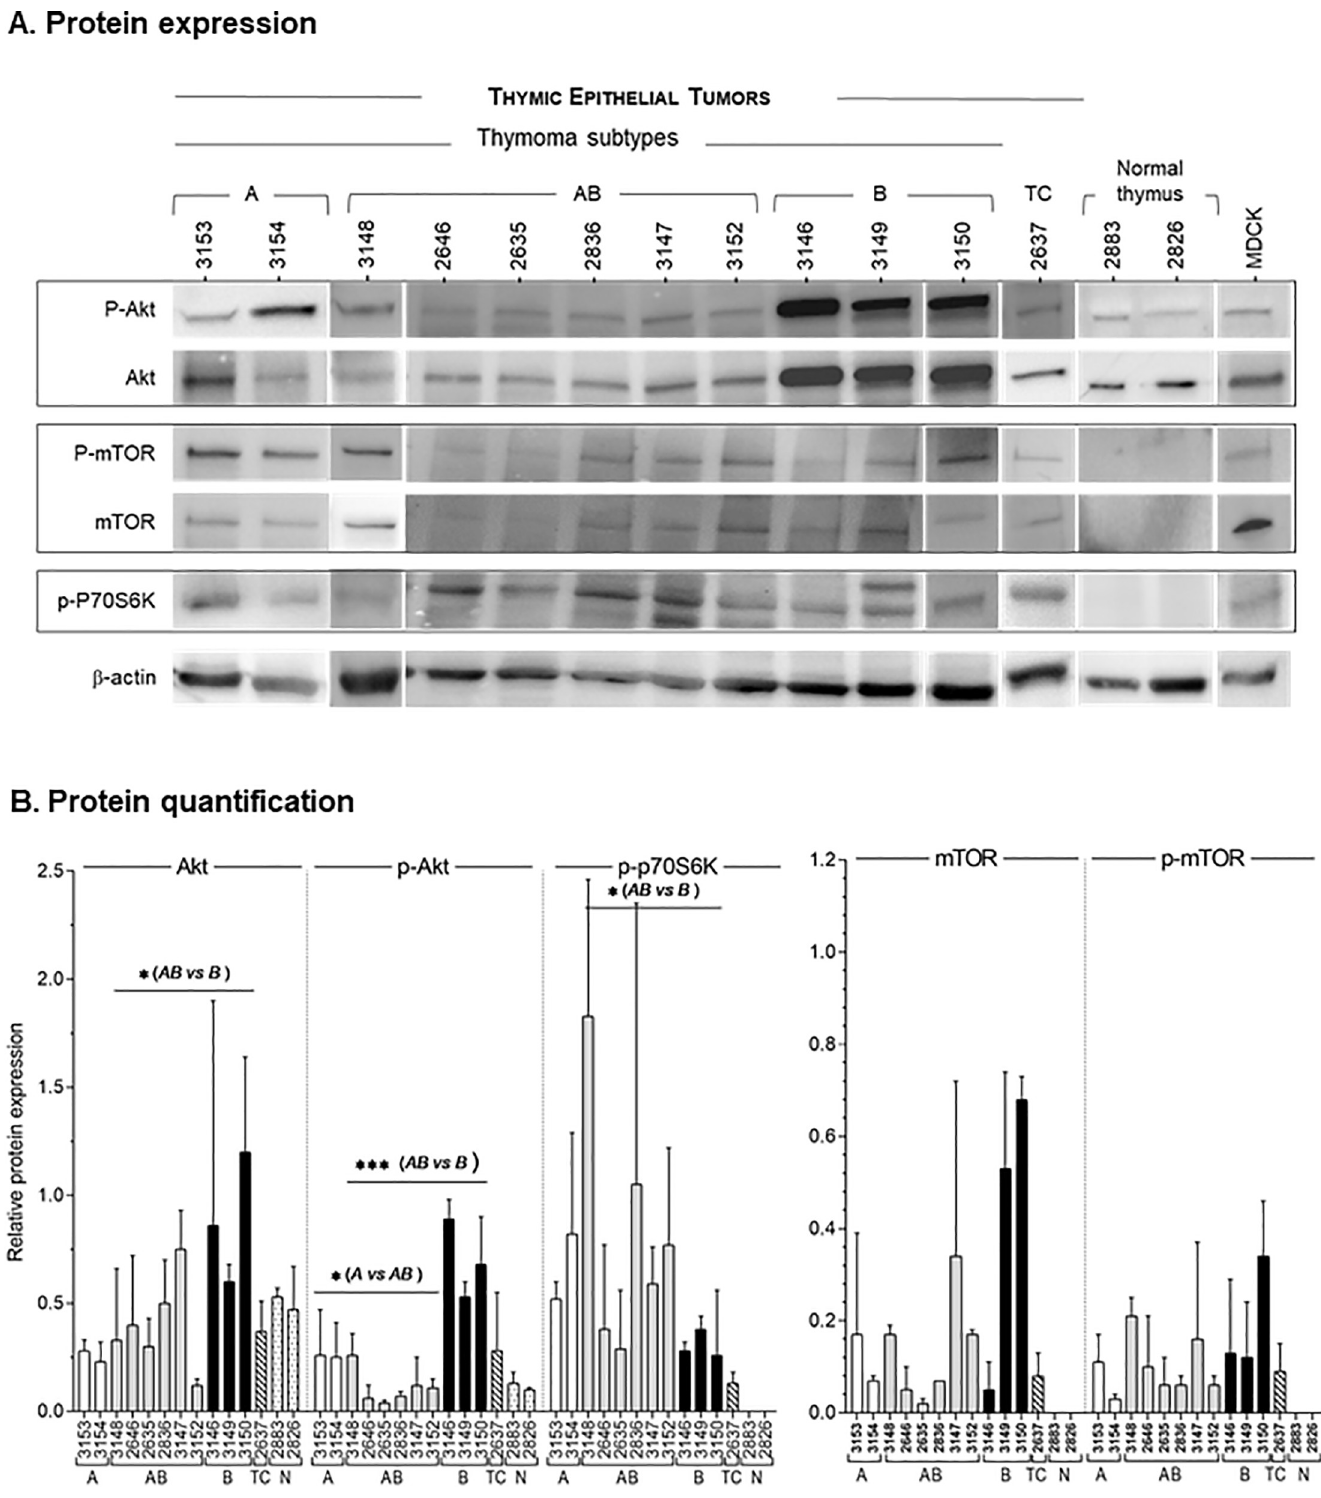
Fig 3. Activation of the Akt/ mTOR pathway in thymic epithelial tumors. A. Total and phosphorylated protein expression was analyzed using antibodies directed against total Akt and phosphorylated- Akt (P- Akt) (60 kDa), total mTOR and phosphorylated- mTOR (P- mTOR) (289 kDa), phosphorylated P70S6K (P- P70S6K) (70 kDa) and β -Actin (40 kDa). B. Protein expression (Akt, phospho- Akt, phospho- P70S6K, mTOR, phospho- mTOR) has been measured and expressed as [protein of interest/ actin] relative expression in A (white bars), AB (grey bars) and B (B2 and B2/ B3; black bars) thymomas, thymic carcinoma (TC, hatched bars) or normal thymus (N, dotted bars). Detection have been repeated at least 3 times. Data have been statistically analyzed with an unpaired T test.